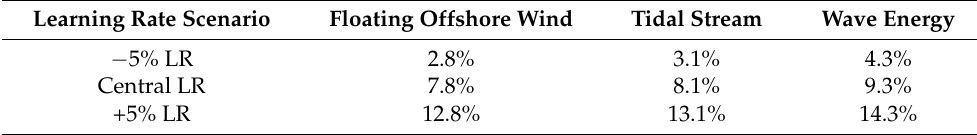
Table 11. Cost-weighted average learning rates applied to CAPEX in the